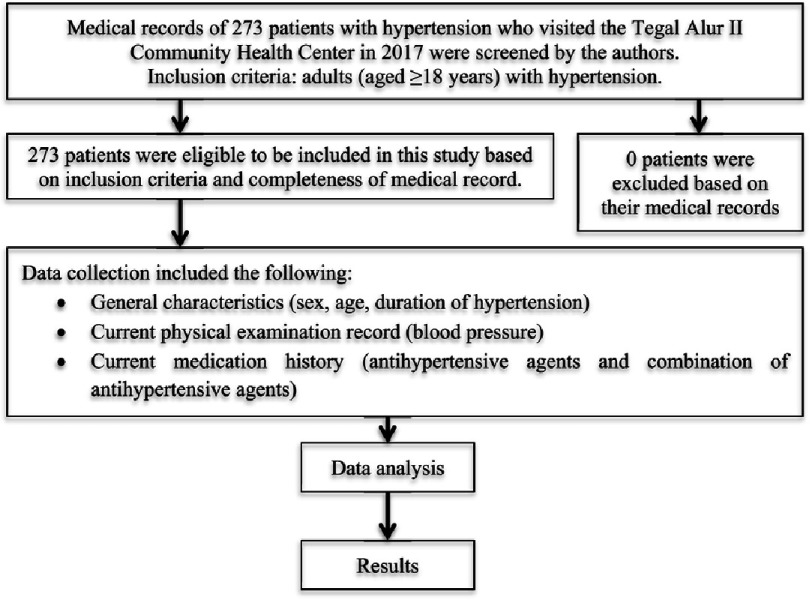
Workflow of the study.